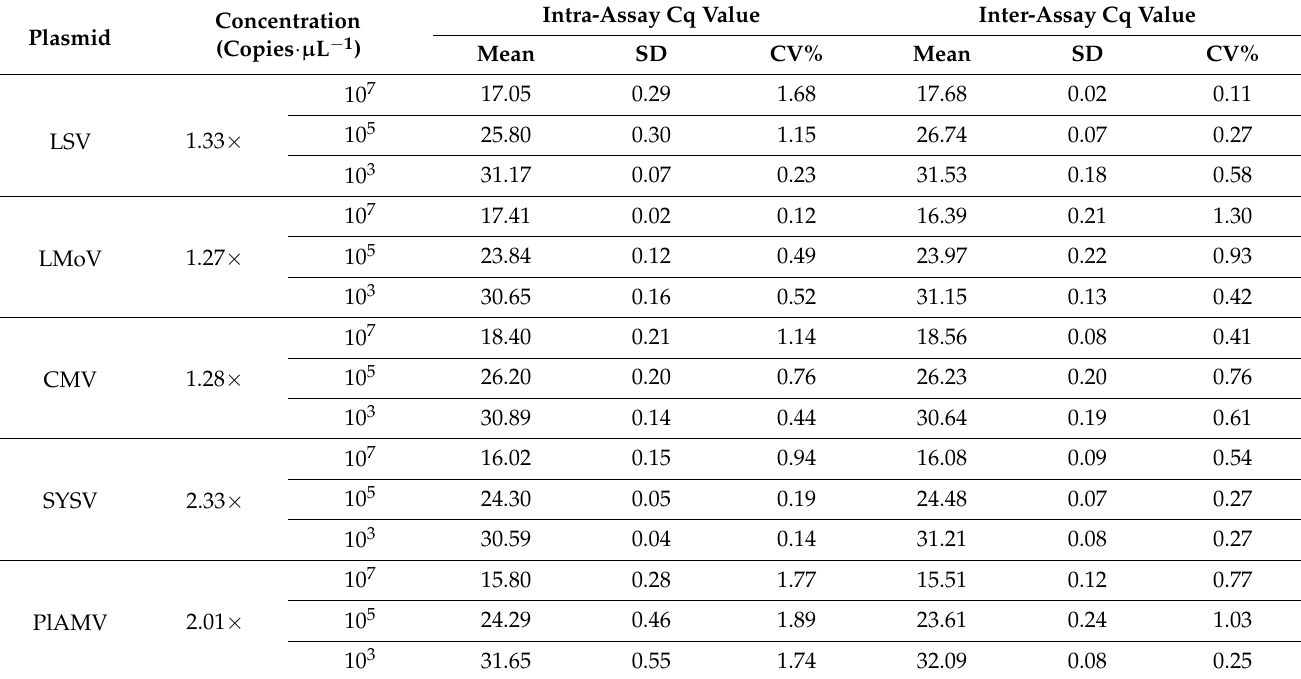
Table 2. Intra- and inter-assay reproducibility of multiplex TaqMan real-time